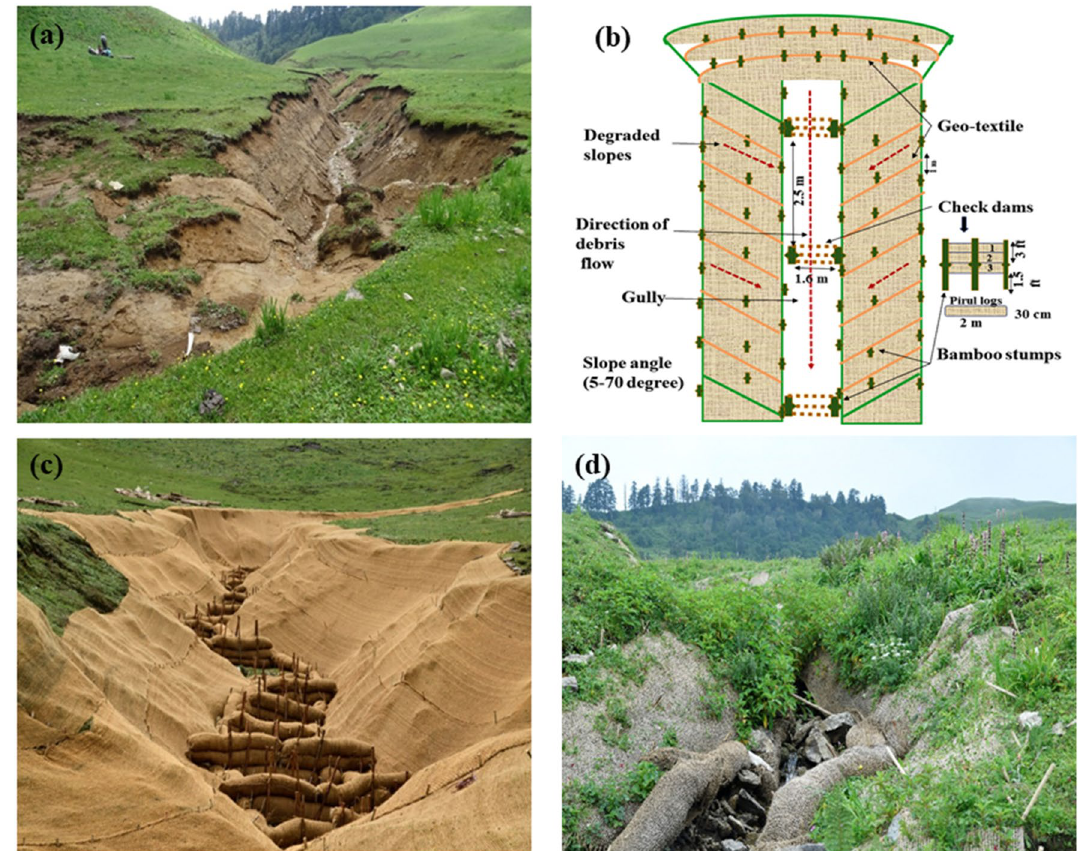
Figure 3. Soil erosion control techniques in the Dayara alpine pasture: ( a ) eroded gully side areas due to biotic and abiotic factors in 2018, ( b ) restoration planning details in 2019, ( c ) field implementation of the plan initiated in 2019, and ( d ) implications of one year outcome of the restoration activity since 13th October,